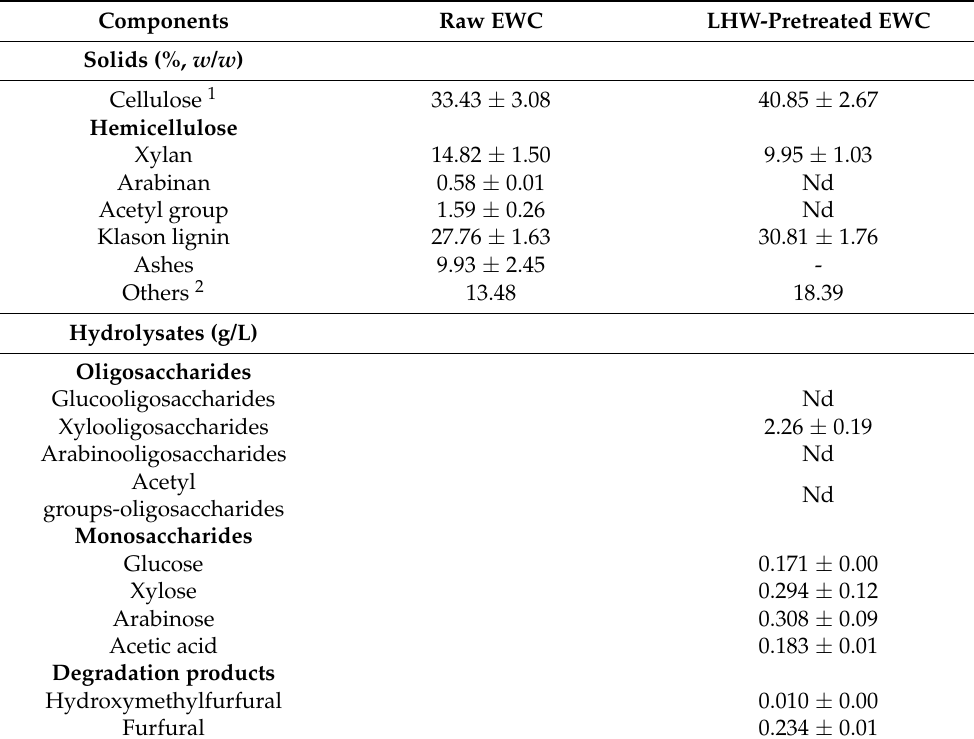
Table 3. Chemical composition of raw and pretreated Eucalyptus grandis wood chips (EWC), expressed as a percentage on a dry weight basis and reported as average values ( ± standard